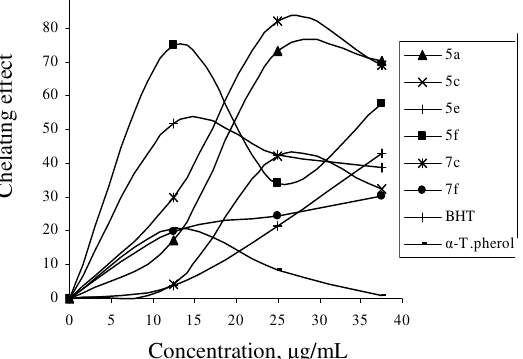
Figure 4. Metal chelating effect of different amount of the compounds 5a, 5c, 5e, 5f, 7c, 7f , BHT and α -tocopherol on ferrous